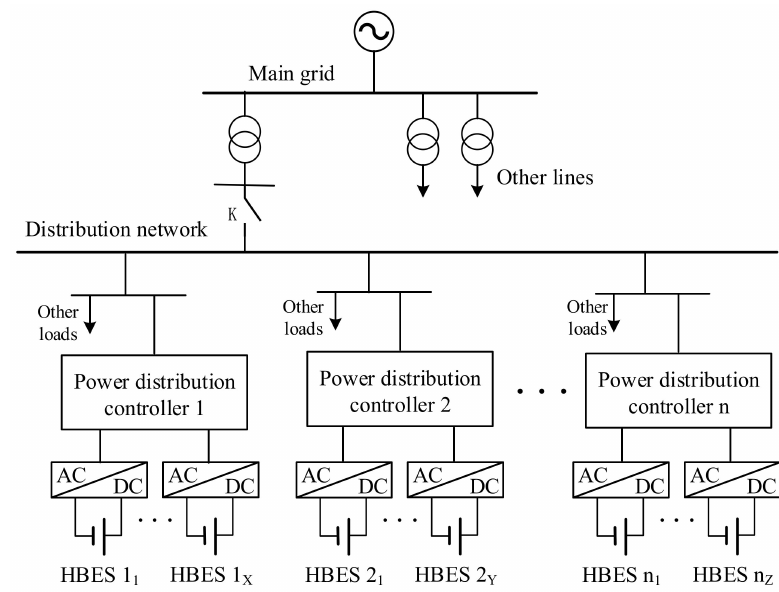
Figure A4. One-line diagram to present the grid